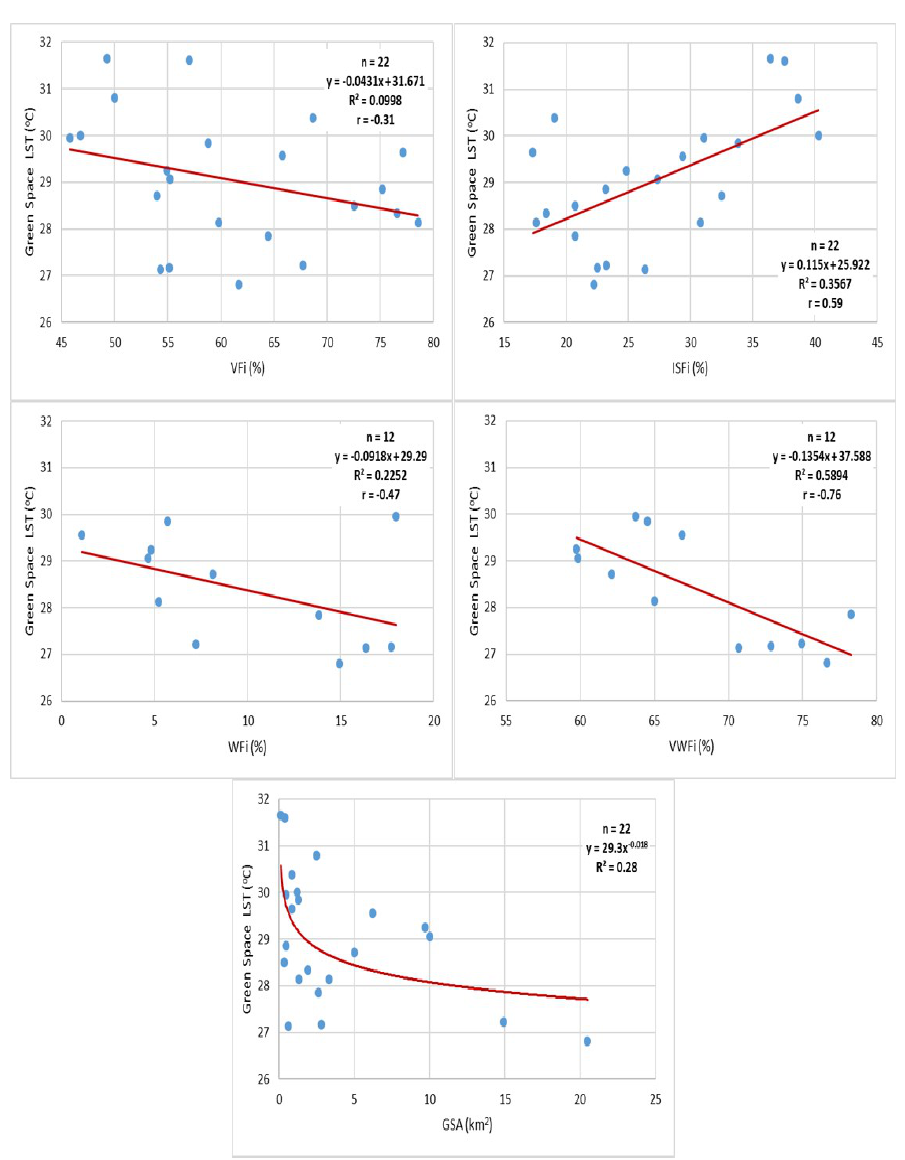
Figure 8. Correlation between LST and impact factors of Beijing. GSA: Green Space